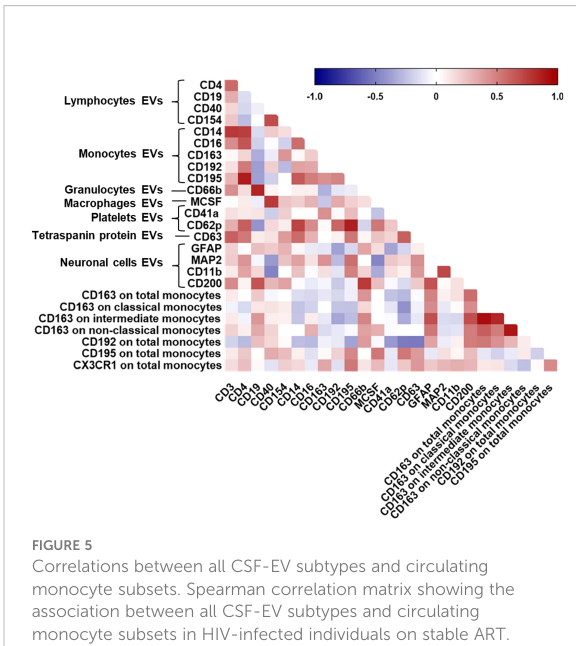
FIGURE 5 Correlations between all CSF-EV subtypes and circulating monocyte subsets. Spearman correlation matrix showing the association between all CSF-EV subtypes and circulating monocyte subsets in HIV-infected individuals on stable ART. Positive correlations are displayed in red shades and negative correlations are in blue shades.